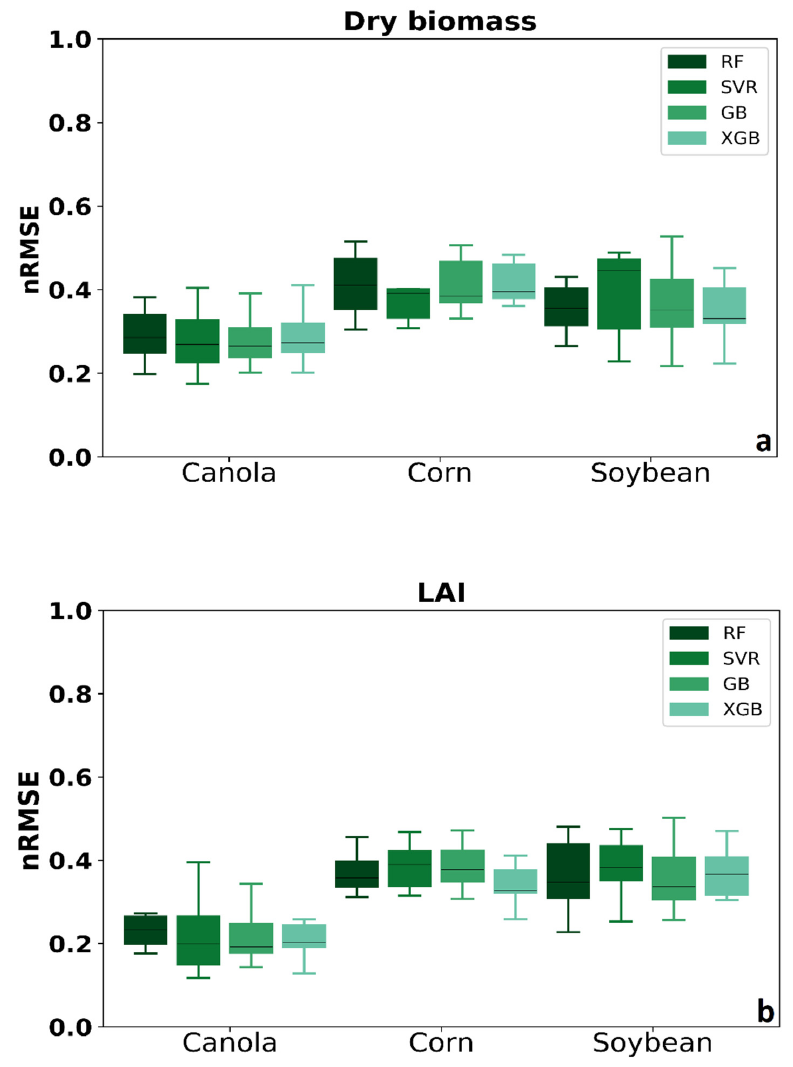
Figure 5. Comparing four MLAs’ nRMSE for three crops ( a ) dry biomass and ( b ) LAI.